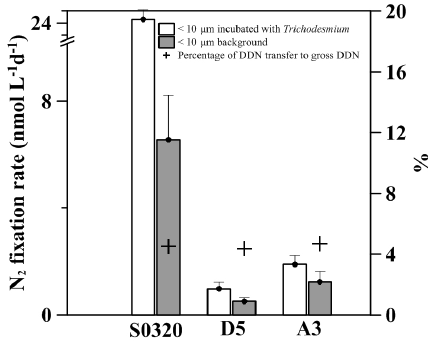
Figure 6. The NF and DDN transfer measured in two treatment groups for stations S0320, D5 and A3. The black bars represent a background NF rate of < 10µm community. White bars repre- sent a NF rate of < 10µm community incubated with > 10µm Tri- chodesmium colonies. The error bar represents the standard devia- tion of the triplicate. Crosses stand for the percentage of DDN trans- ferred to the < 10µm community to total N 2